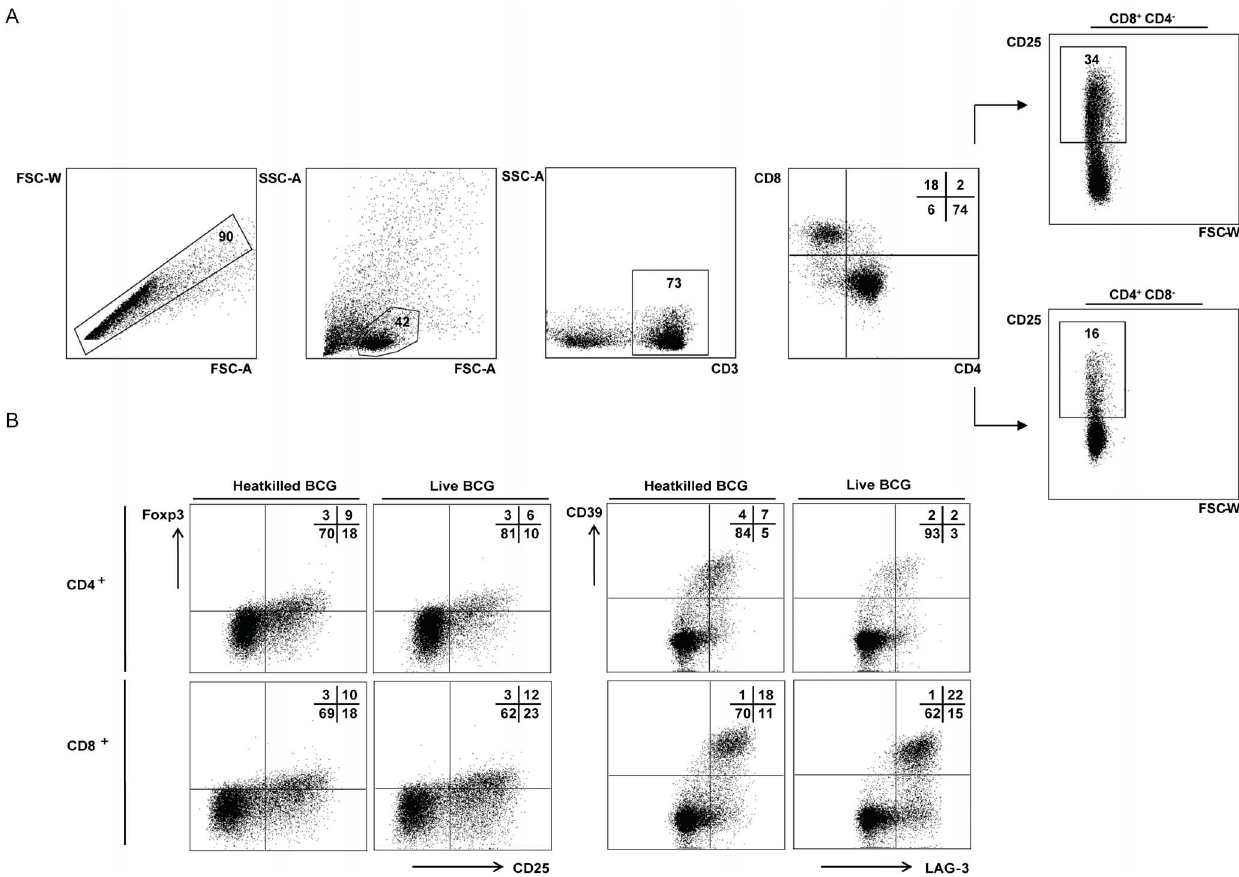
Figure 1. Heatkilled vs. live BCG-activated expression of Treg-cell markers on CD4 + and CD8 + T cells. A: Gating strategy: cells were gated on single cells, live lymphocytes, CD3 + and CD4 + CD8 2 vs. CD4 2 CD8 + . Demonstrated is the synchronized gating on the positive population of interest for CD4 + CD8 2 and CD8 + CD4 2 T cells; here the CD25-positive population. B: Heatkilled and live BCG activate CD25 + Foxp3 + and LAG-3 + CD39 + T cells. Expression of regulatory T cell markers on CD4 + and CD8 + T cells of in vitro PPD responders was analysed by flowcytometry six days after heatkilled or live BCG stimulation. For each donor gating was compared to samples not stimulated with BCG (demonstrated in Fig. S1). Data are representative of seven responders.